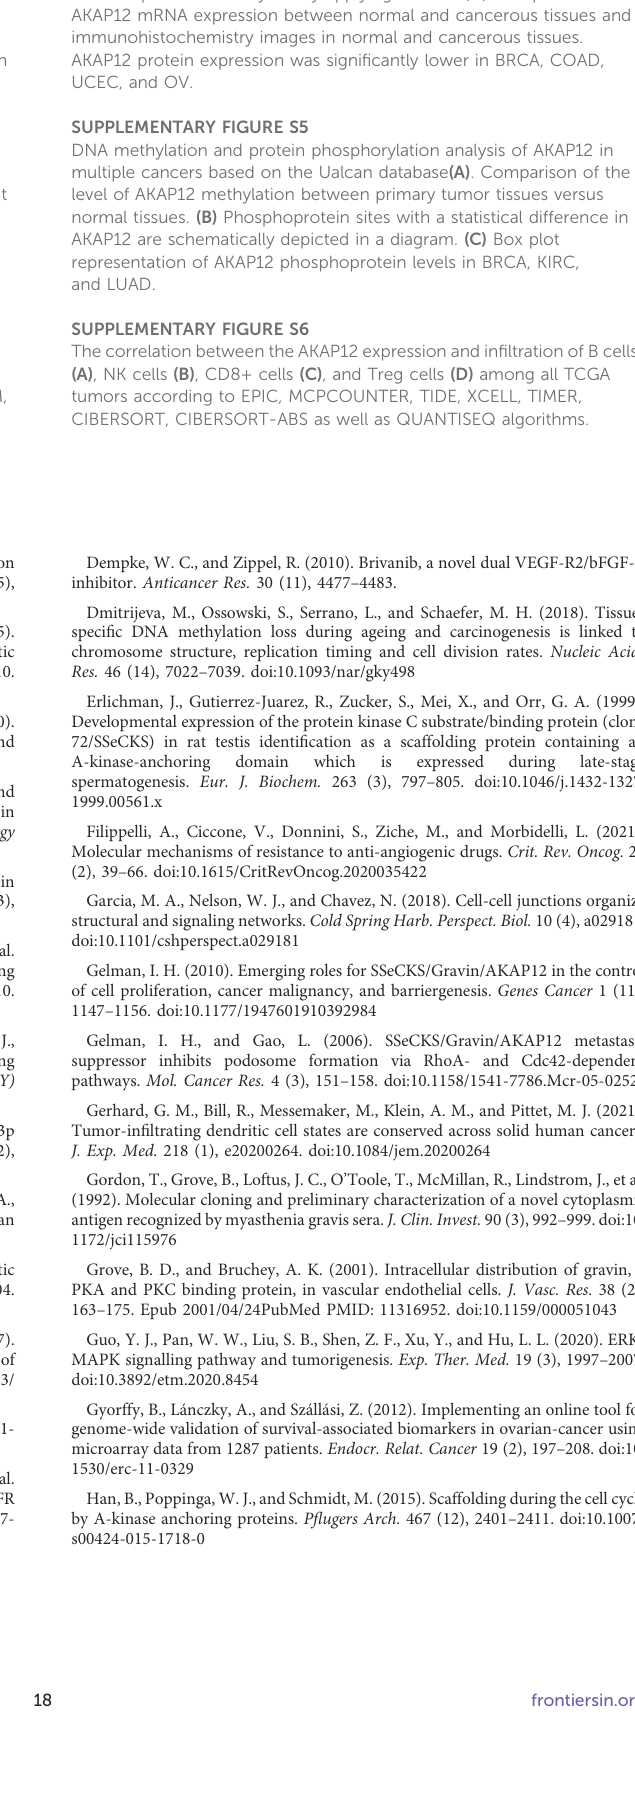
SUPPLEMENTARY FIGURE S2 Prognostic signi fi cance of INSIG1 in OV, GBM, CRC patients treated with BV. The prognostic signi fi cance of INSIG1 in OV patients (A) , GBM patients (B) , and CRC patients (C) following BV treatment. OS, overall survival; PFS, progression-free survival; PPS, post-progression survival. SUPPLEMENTARY FIGURE S3 Correlation between AKAP12 expression and OV (A) and GC (B) patient